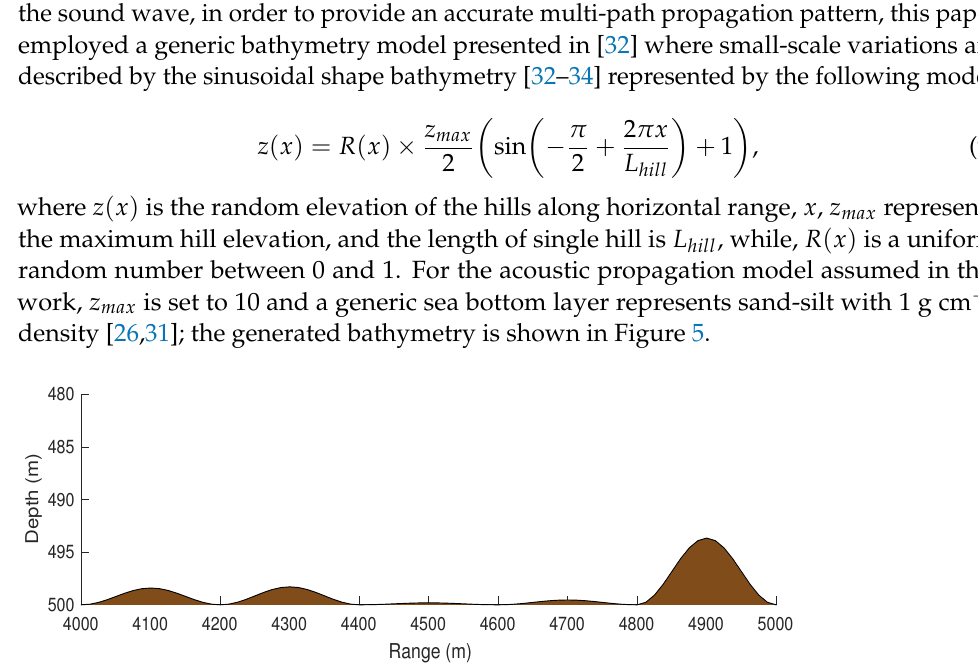
Figure 5. Sinusoidal bathymetry with 200 m long hills and random hill